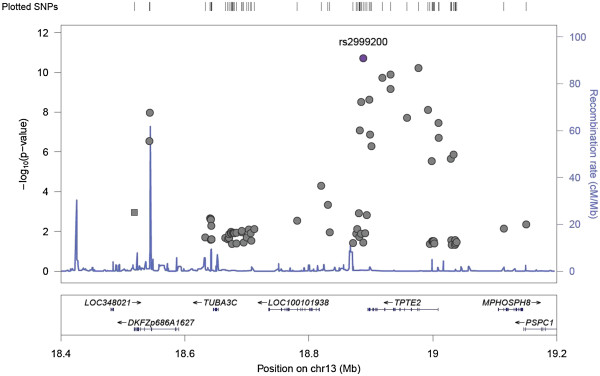
A regional view of a genome-wide scan for miR-eQTLs. Shown here is a regional plot that illustrates the eQTL mapping for miR-200c, a molecule that has been reported to successfully distinguish hepatocellular carcinoma from liver metastases.